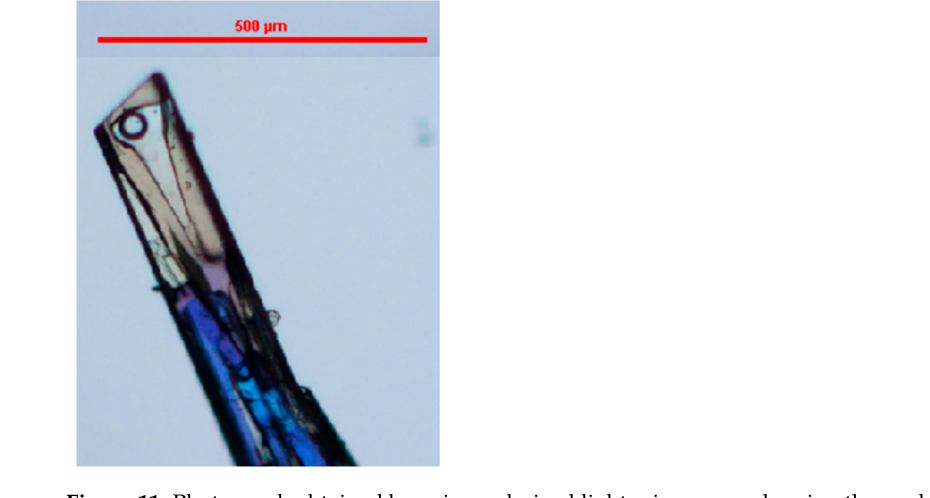
Figure 11. Photograph obtained by using polarized light microscopy showing the angle disruption in the conical shape fluid inclusion.